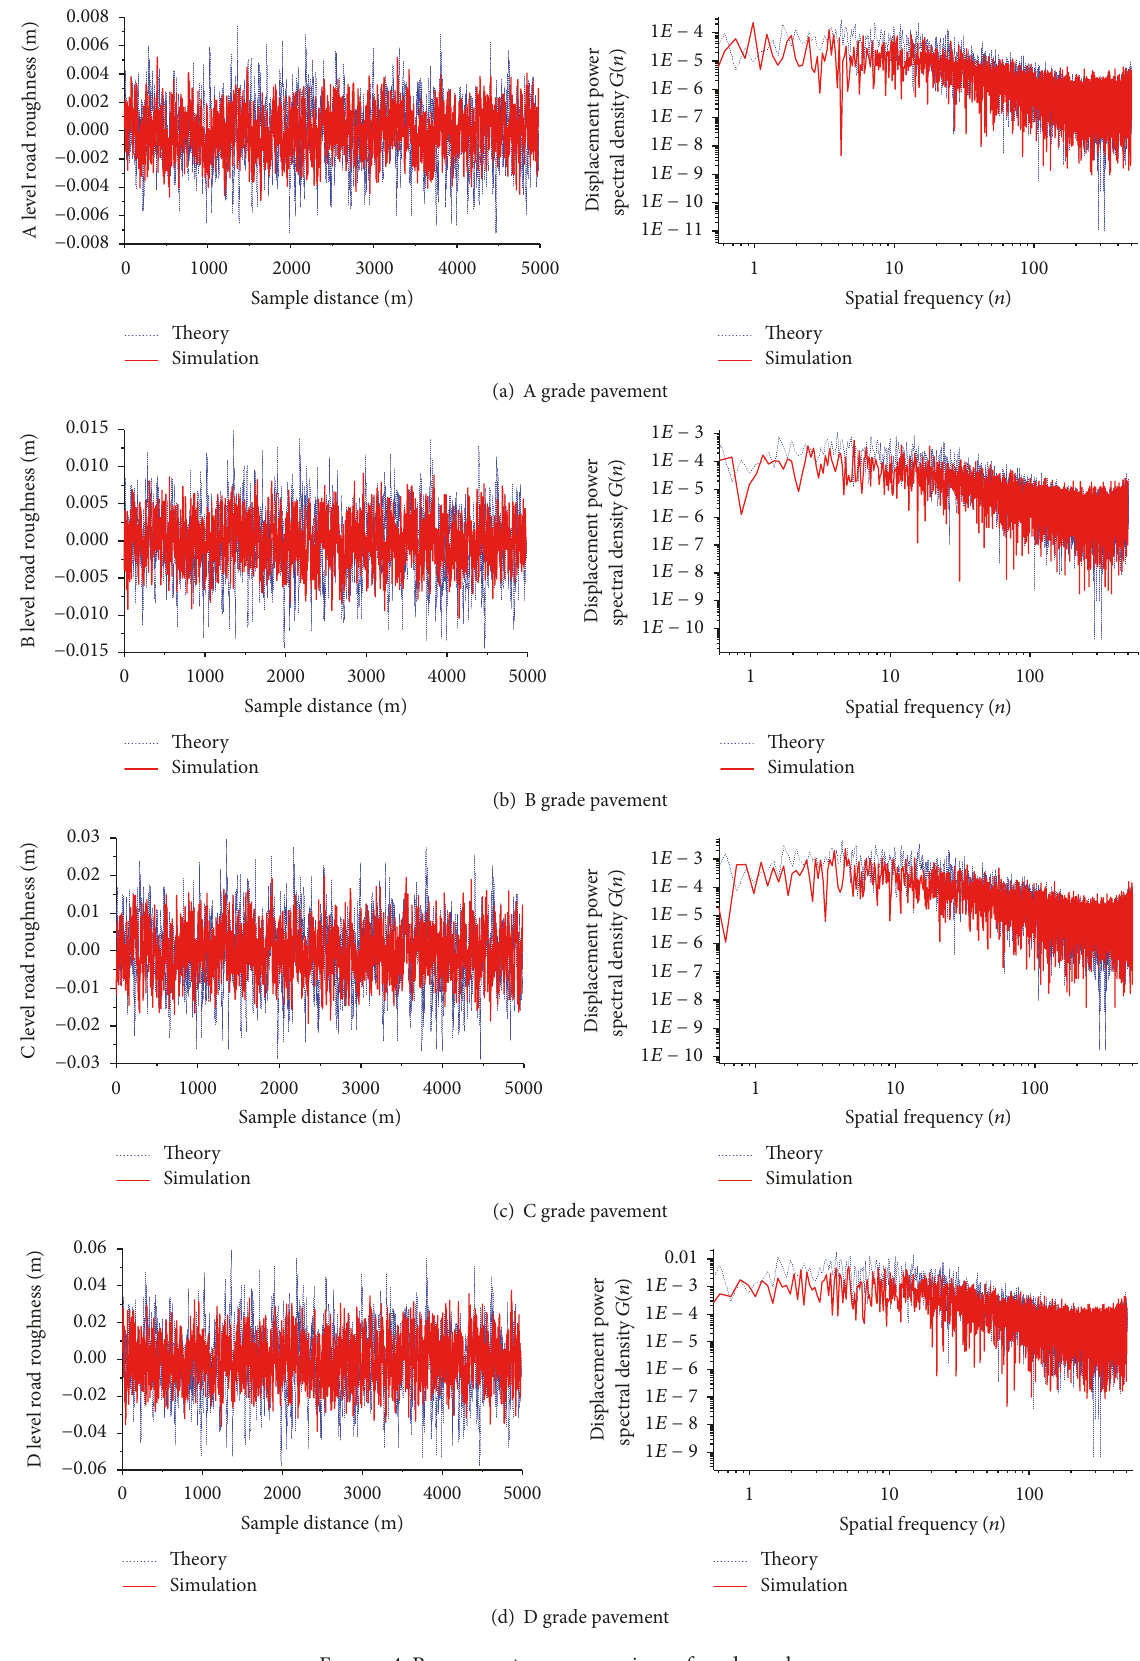
Figure 4: Power spectrum comparison of road